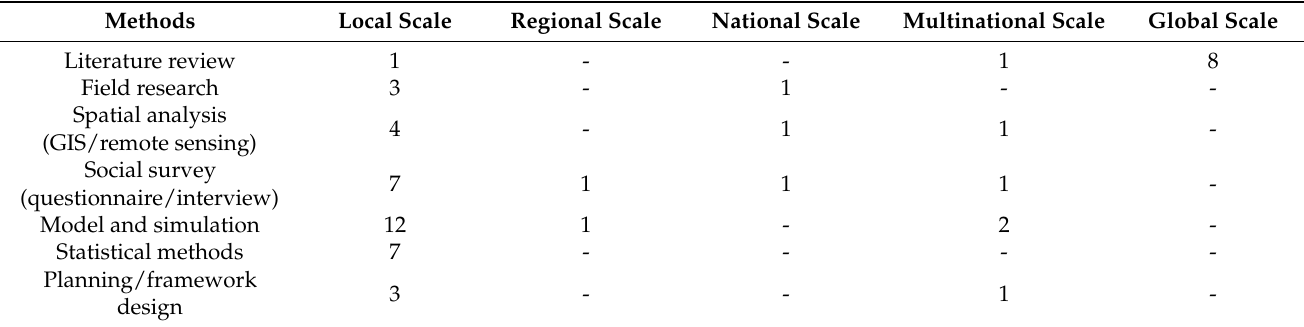
Table 4. Typologies of research methods and research scales in analyzed